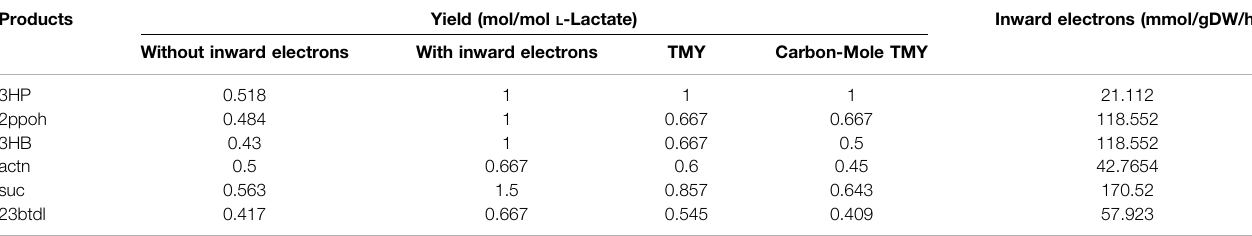
TABLE 2 | Simulation results for the synthesis of six products in MESs. Products Yield (mol/mol L -Lactate) Inward electrons (mmol/gDW/h) Without inward electrons With inward electrons TMY Carbon-Mole